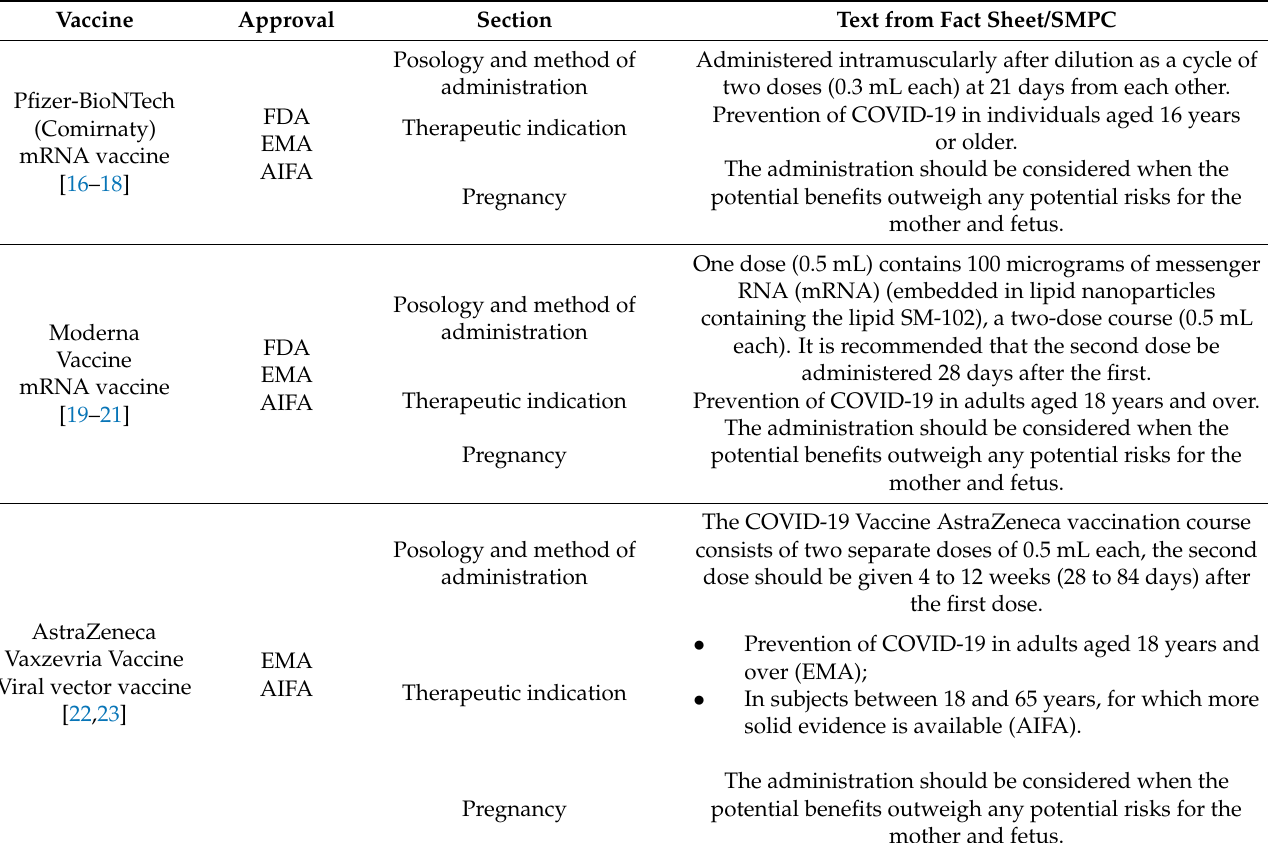
Table 2. Summary of COVID-19 vaccine characteristics according to FDA, EMA, and AIFA. Vaccine